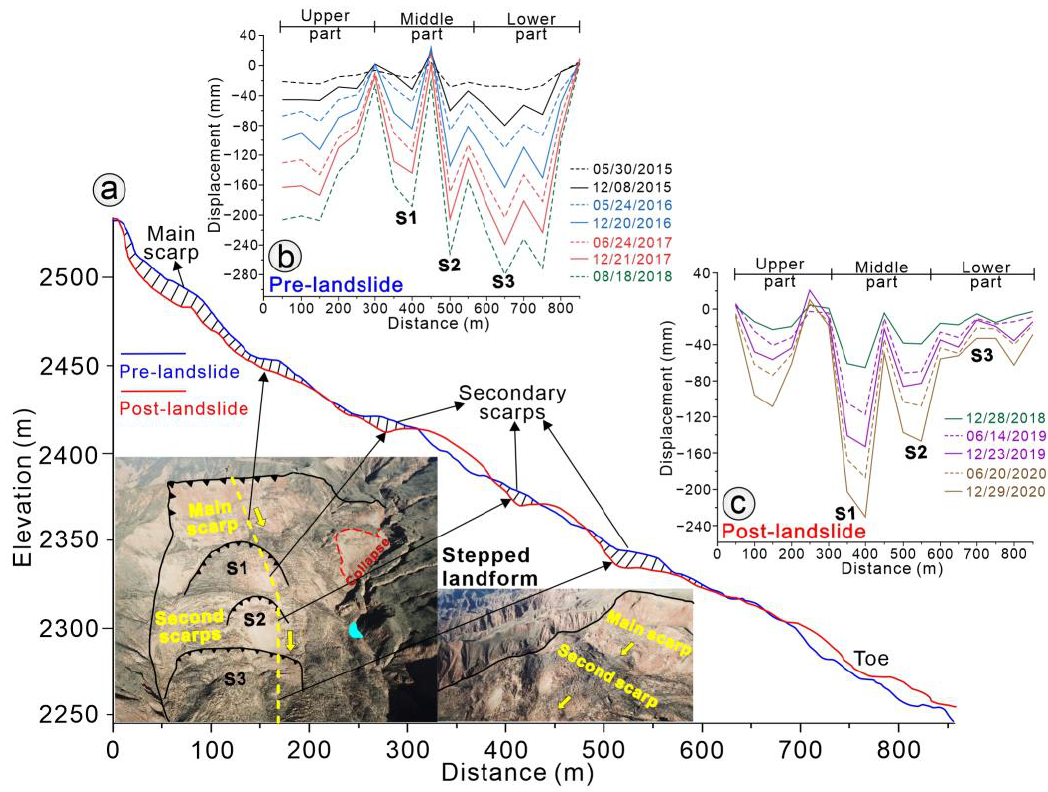
Figure 7. Longitudinal ground surface displacement profile along the main sliding direction before and after the landslide.